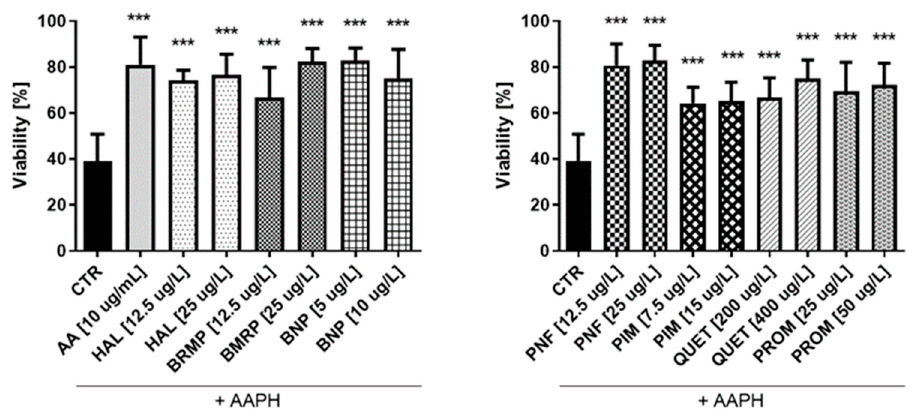
Figure 8. Potential antioxidative effect of selected antipsychotics in HUVEC cells. The experiments were performed by assessing the viability of HUVEC cells using the WST-1 assay. The cells were incubated for 1 h with the test compounds, and then AAPH, which was an inducer of oxidative stress, was added. The results are presented relative to control treated with pure medium (100% viability). An asterisk denotes a statistically significant difference between the control (CTR, in which were cells treated with pure AAPH [17.5 mmol/L]) and samples co-treated with antipsychotics and AAPH; *** p < 0.001.